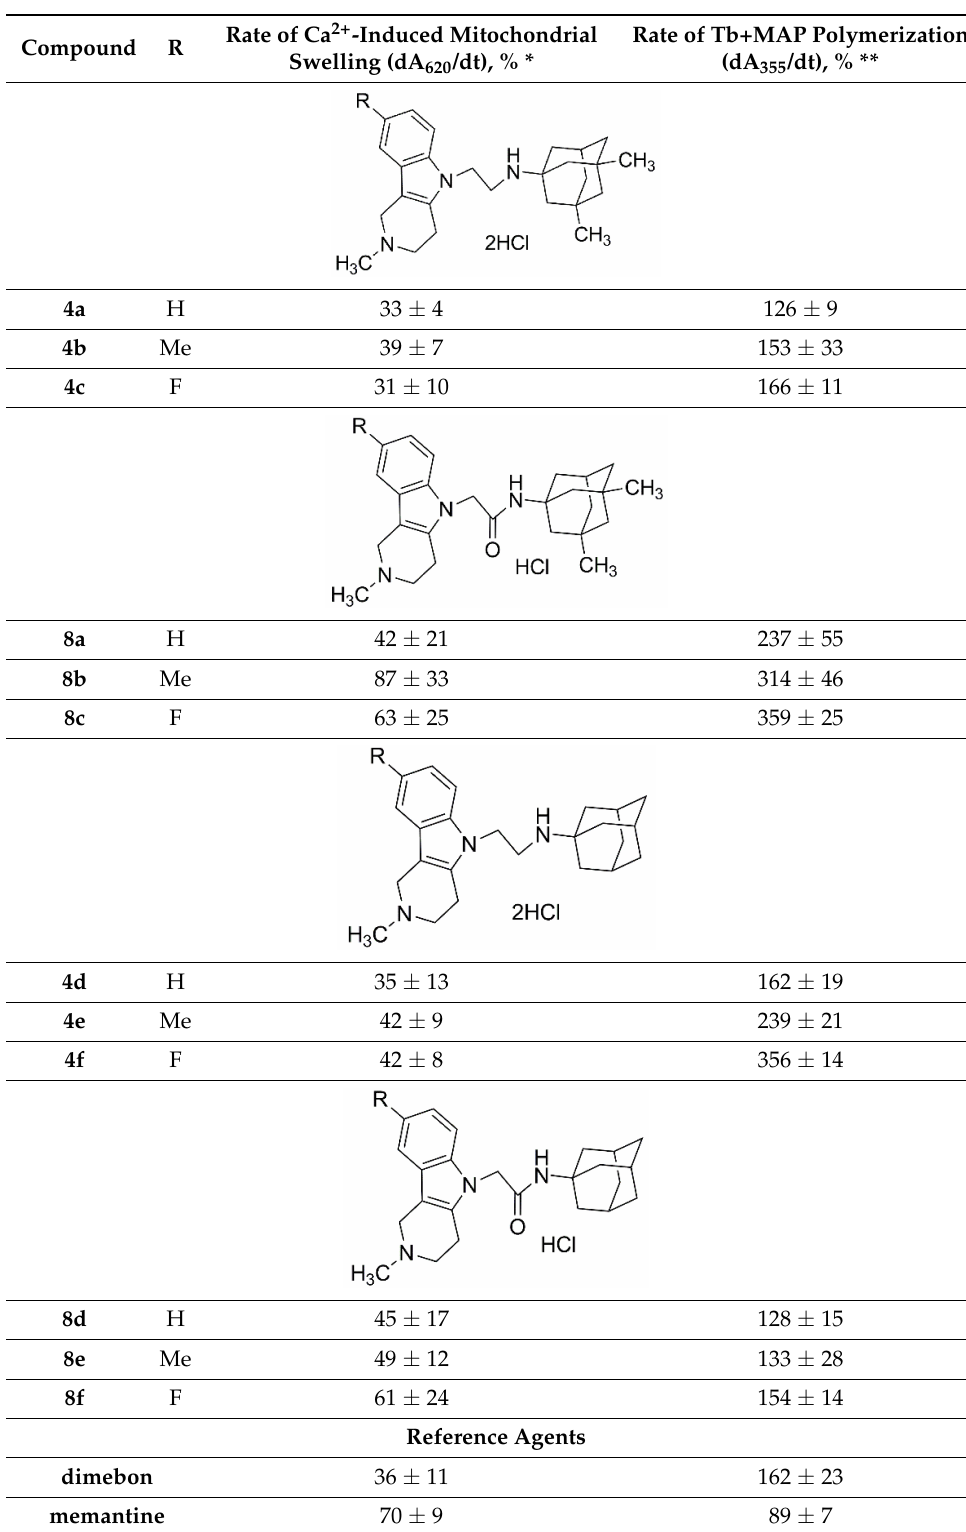
Table 3. Effects of compounds on the calcium-induced MPT pore opening and the rate of GTP- dependent Tb+MAP